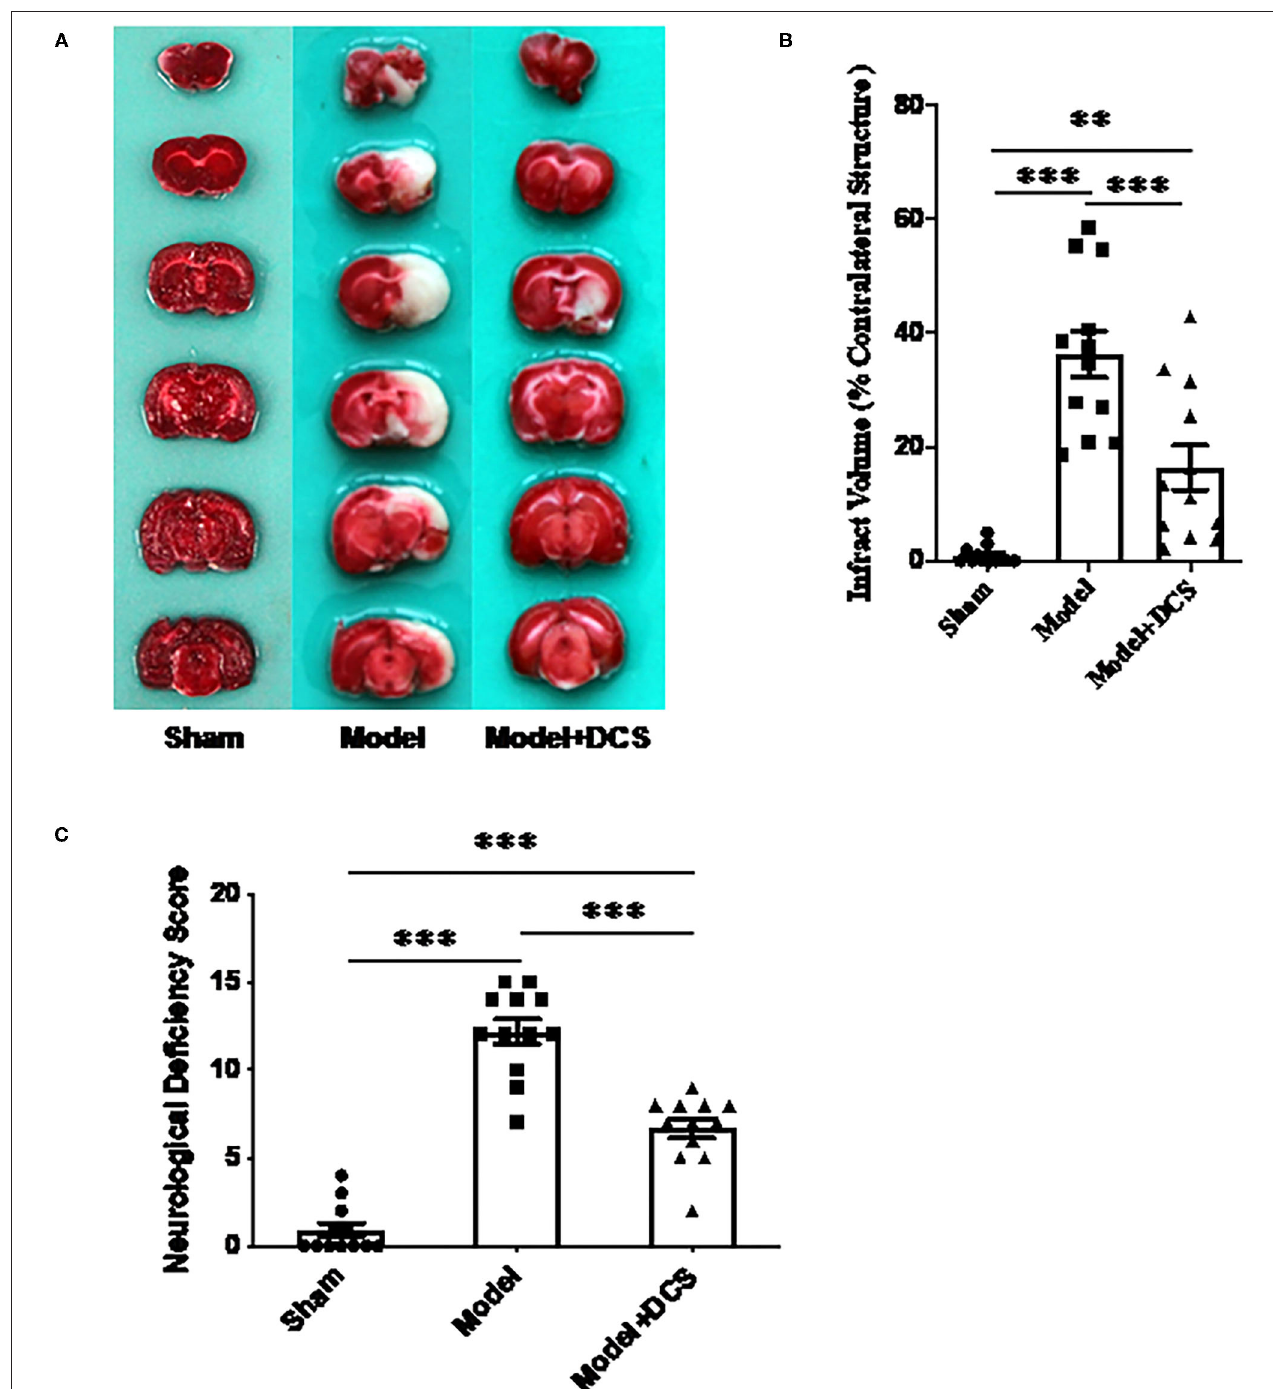
FIGURE 1 | Effects of deproteinized calf serum (DCS) on neurological dysfunction and infarct volume in the rat model of ischemic stroke. (A) Representative photographs illustrating infarcted regions in the right side of the brain that had not stained with triphenyltetrazolium chloride (unstained areas were defined as infarcted tissue, while normal tissue was stained red). Sham: animals only went through anesthesia with isoflurane until CCA, ECA, lCA, and vagus nerve were exposed and isolated carefully then close the incision. Model + DCS: rats with ischemic stroke administered DCS in normal saline; Model: rats with ischemic stroke administered normal saline (vehicle) only. (B) Statistic analysis for (A) . Data shown as mean ± standard error of the mean (SEM). ** p < 0.01, *** p < 0.0005. (C) Neurological dysfunction assessed using the neurological deficiency score (modified Bederson’s method). Twelve rats per group were performed. Data shown as mean ± SEM. *** p <